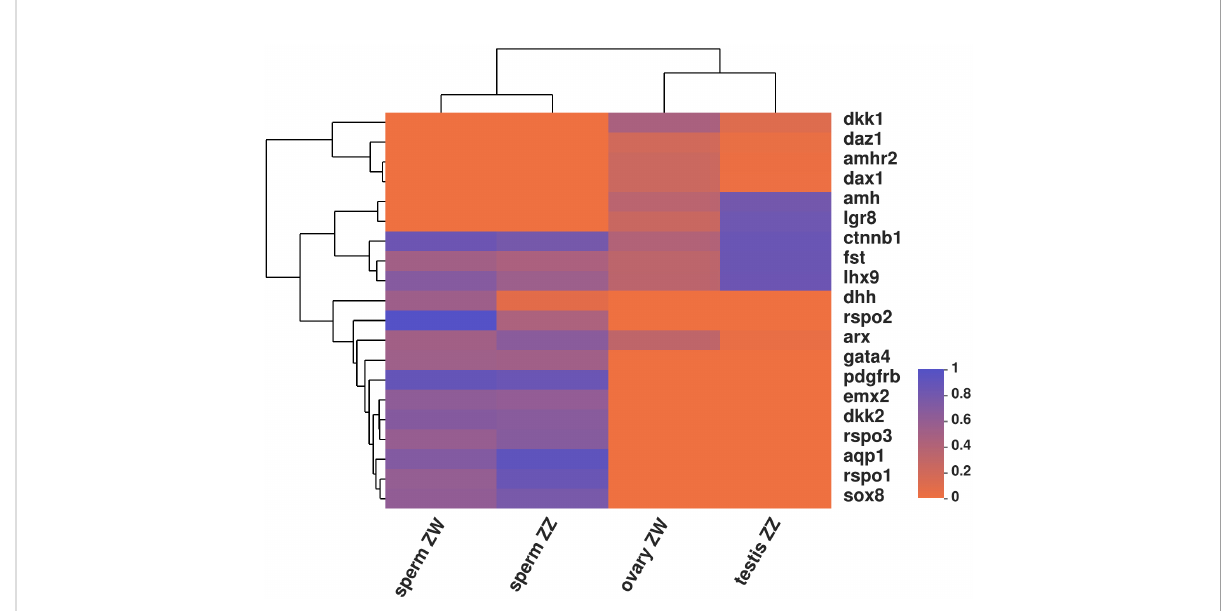
FIGURE 6 Heatmap of mean methylation levels on 20 sex related genes between sperm and gonad from C. semilaevis